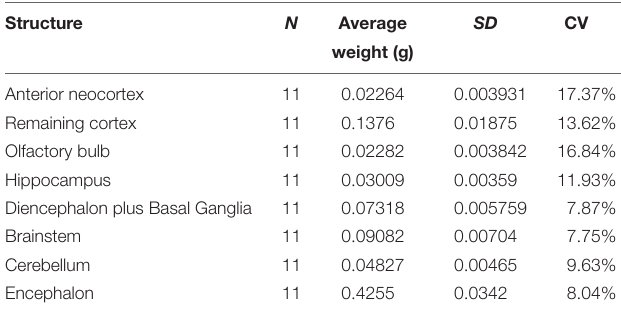
TABLE 1 | Average weight of dissected structures and of the whole brain (both hemispheres), standard deviations ( SD ), and coefficients of variation (CV).